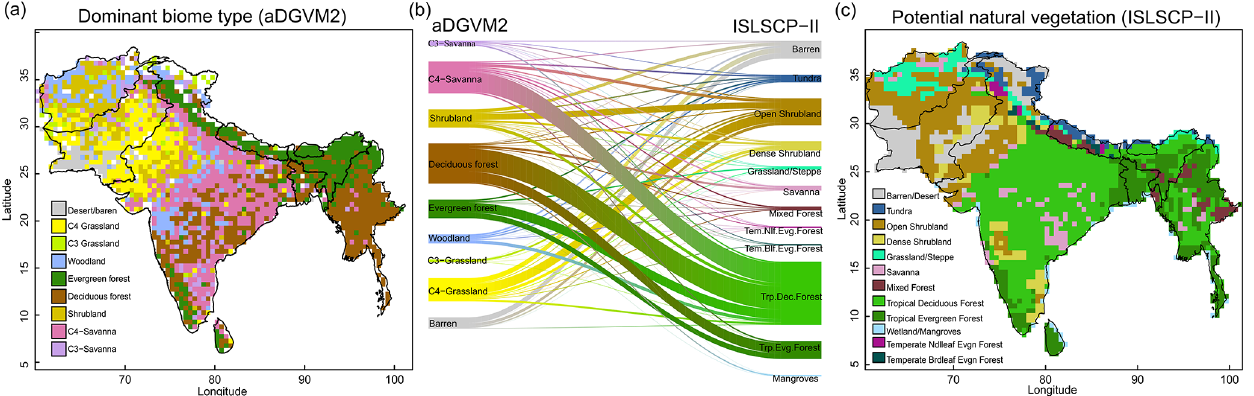
Figure 2. Comparison between simulated and observed biome patterns. (a) Simulated dominant biome type, (b) Sankey diagram showing overlap between simulated biomes and potential natural vegetation cover (ISLSCP II, Ramankutty et al., 2010), and (c) potential natural vegetation. The Sankey graph shows how aDGVM2 biomes and PNV classes overlap.